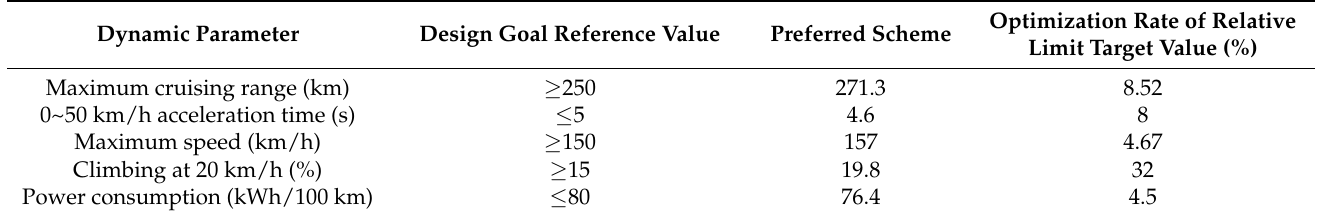
Table 15. Comparative analysis of performance and design objectives of optimization scheme.